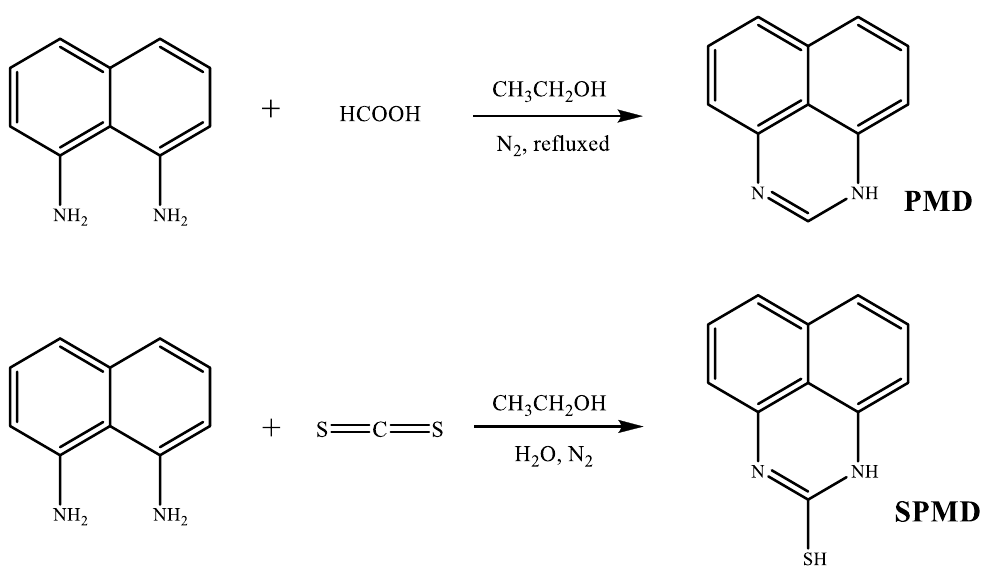
Figure 1. Synthesis routes of PMD and SPMD.